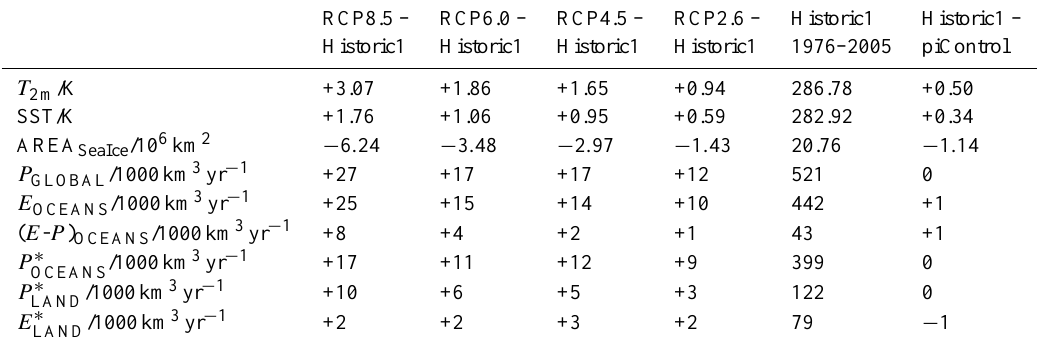
Table 5. Simulated changes in selected global annual data with NorESM1-M from the period 1976–2005 (Historic1) to 2071–2100 based on the four projected representative concentration pathways (RCP) scenarios. The hydro-climatic quantities marked with a star ( ∗ ) are estimated using the fact that E GLOBAL = P GLOBAL in the model. The rightmost columns contain total values simulated for 1976–2005 (Historic1), and the difference between this and piControl.